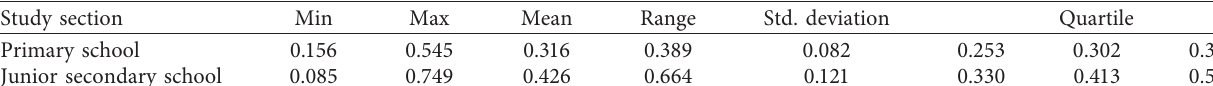
Table 3: Comprehensive evaluation results.